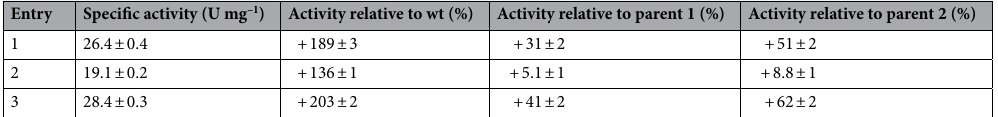
Table 2. The specific activities of the variants OxdB-D1 to OxdB-D3 and the relative activities compared to the wild-type protein and the corresponding parent variants.